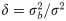
The power of QTL detection for each QTL under different block variances.(A) δ = 0.5; (B) δ = 1; (C) δ = 5; (D) δ = 10. δ represents the size of the block variance and is defined as δ=σb2/σ2, where σ
2 is the error variance and σb2 is the variance of a block within the replication. For the purpose of computing the detection power, a predefined QTL counted as detected if at least one QTL was found within a 10 cM window centered at the true QTL. A permutation test with 1000 replications was used to determine the threshold.